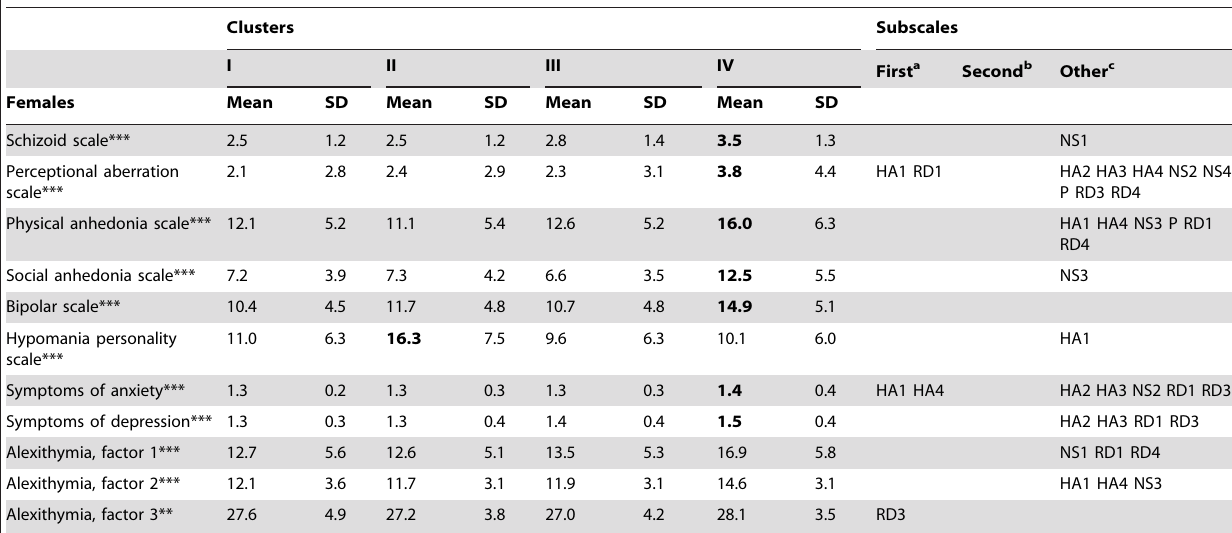
Table 5. Psychological scales for females.